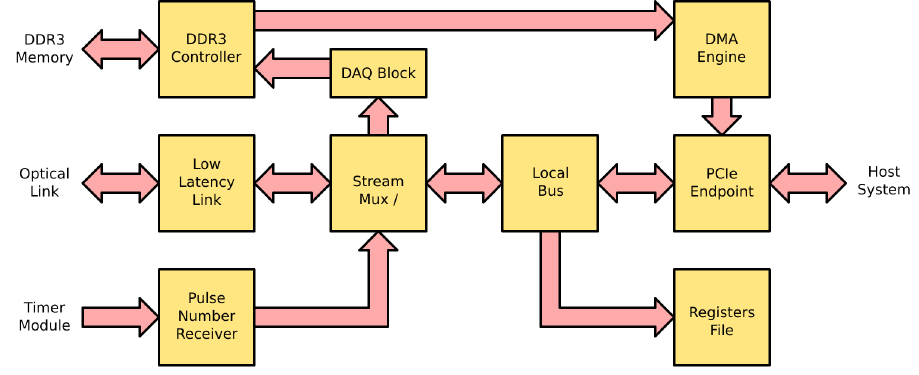
Figure 9. A block diagram of DTM FPGA